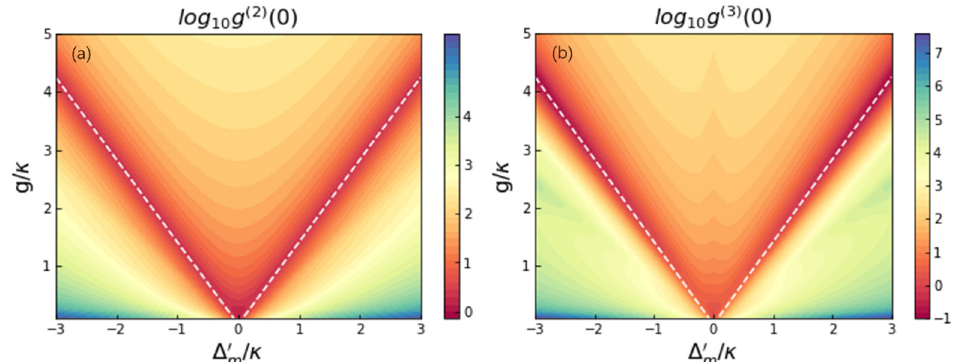
Figure 4. Steady-state equal-time ( a ) second-order correlation function g ( 2 ) ( 0 ) and ( b ) third-order correlation function g ( 3 ) ( 0 ) versus the detuning ∆ (cid:48) m / κ and the coupling strength g / κ when the optical cavity is weakly driven. The system parameters we take are γ = 0.01 κ , ε d = 0.15 κ and n th = 0. The white dashed curves in ( a ) and ( b ) correspond to the cases of two-phonon resonant driving, i.e., ∆ (cid:48) 2 = ± g . 2 m 2